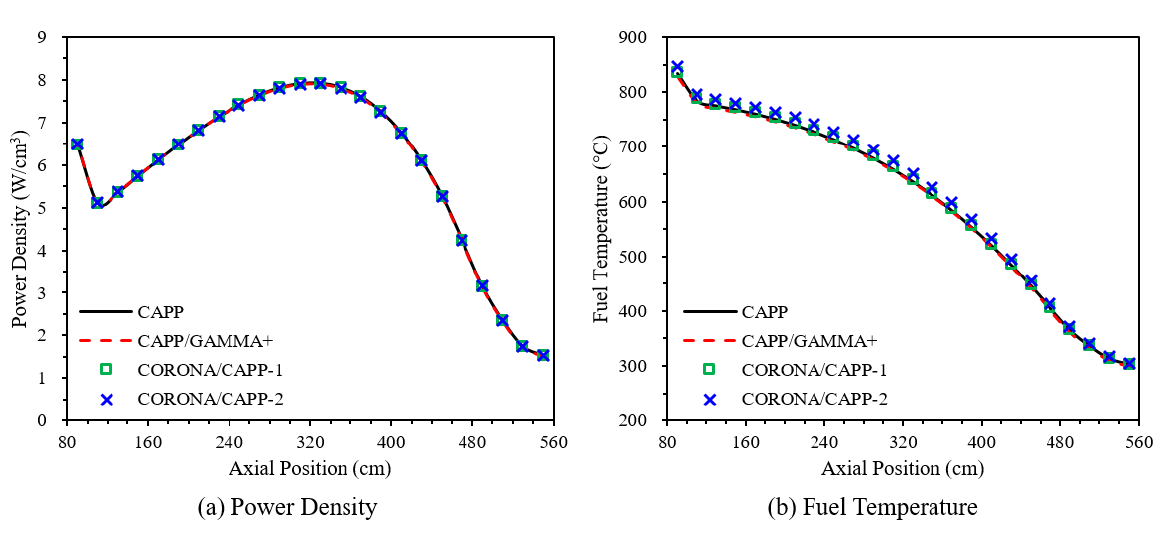
Figure 5. Axial Distribution for Single Column